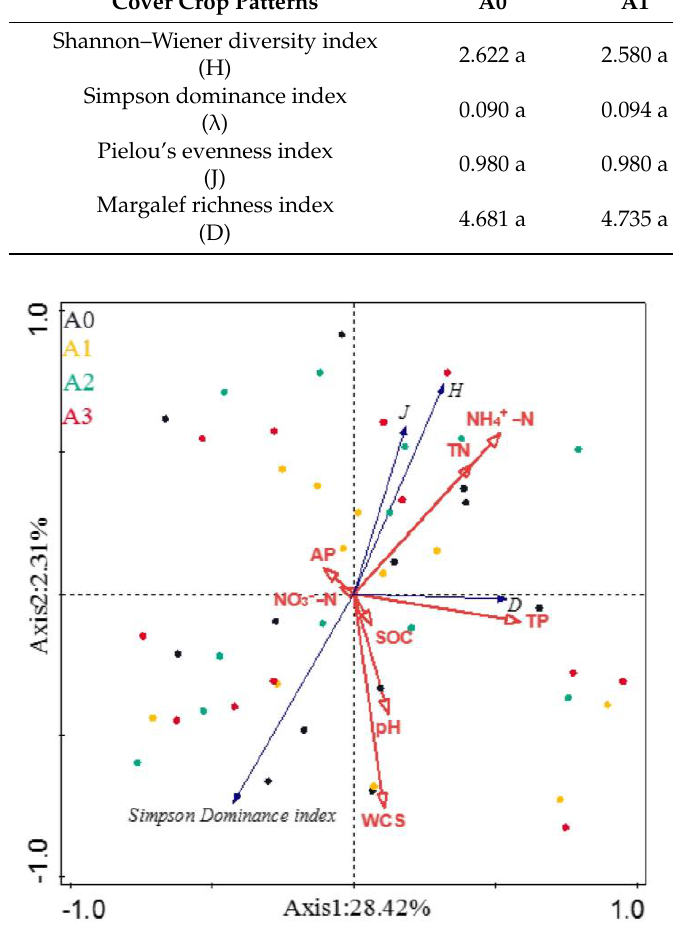
Figure 6. Correlation between the edaphic physicochemical factors and the microbial communities diversity index. J, Pielou’s evenness index; H, Shannon–Wiener diversity index; D, Margalef richness index; TN, total nitrogen; TP, total phosphorus; AP, available phosphorus; SOC, soil organic carbon; WCS, water content of soil; NO 3 − -N, nitrate; NH 4+ -N, ammonium.